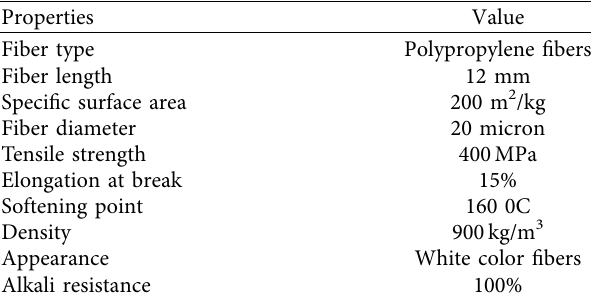
Table 2: Properties of added polypropylene